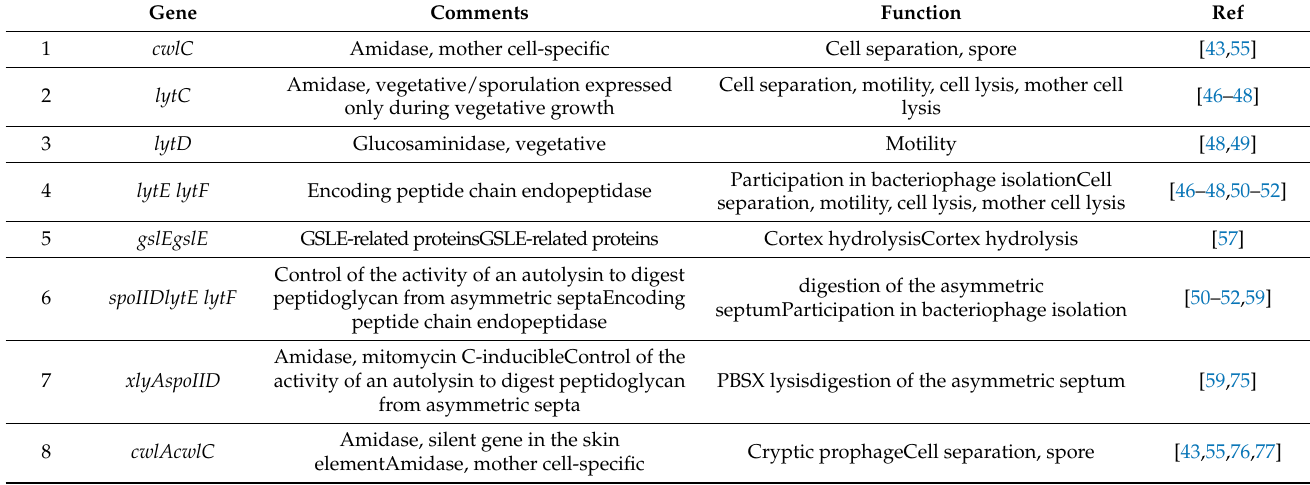
Table 1. Summary of peptidoglycan hydrolase-related